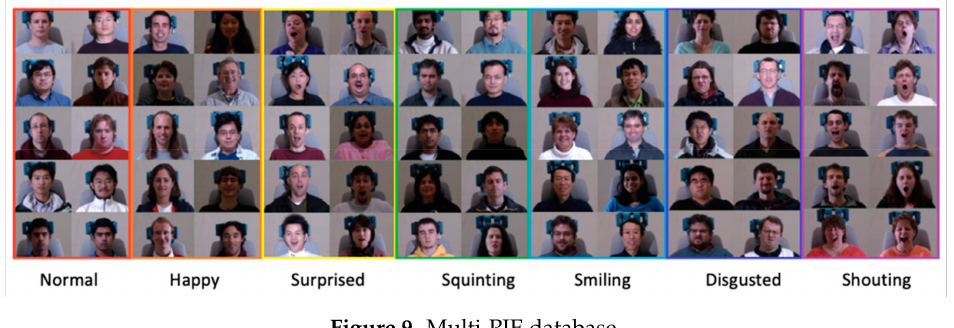
Figure 9. Multi-PIE database. Table 1. Recognition results of di ff erent architectures with Adagrad optimization method.